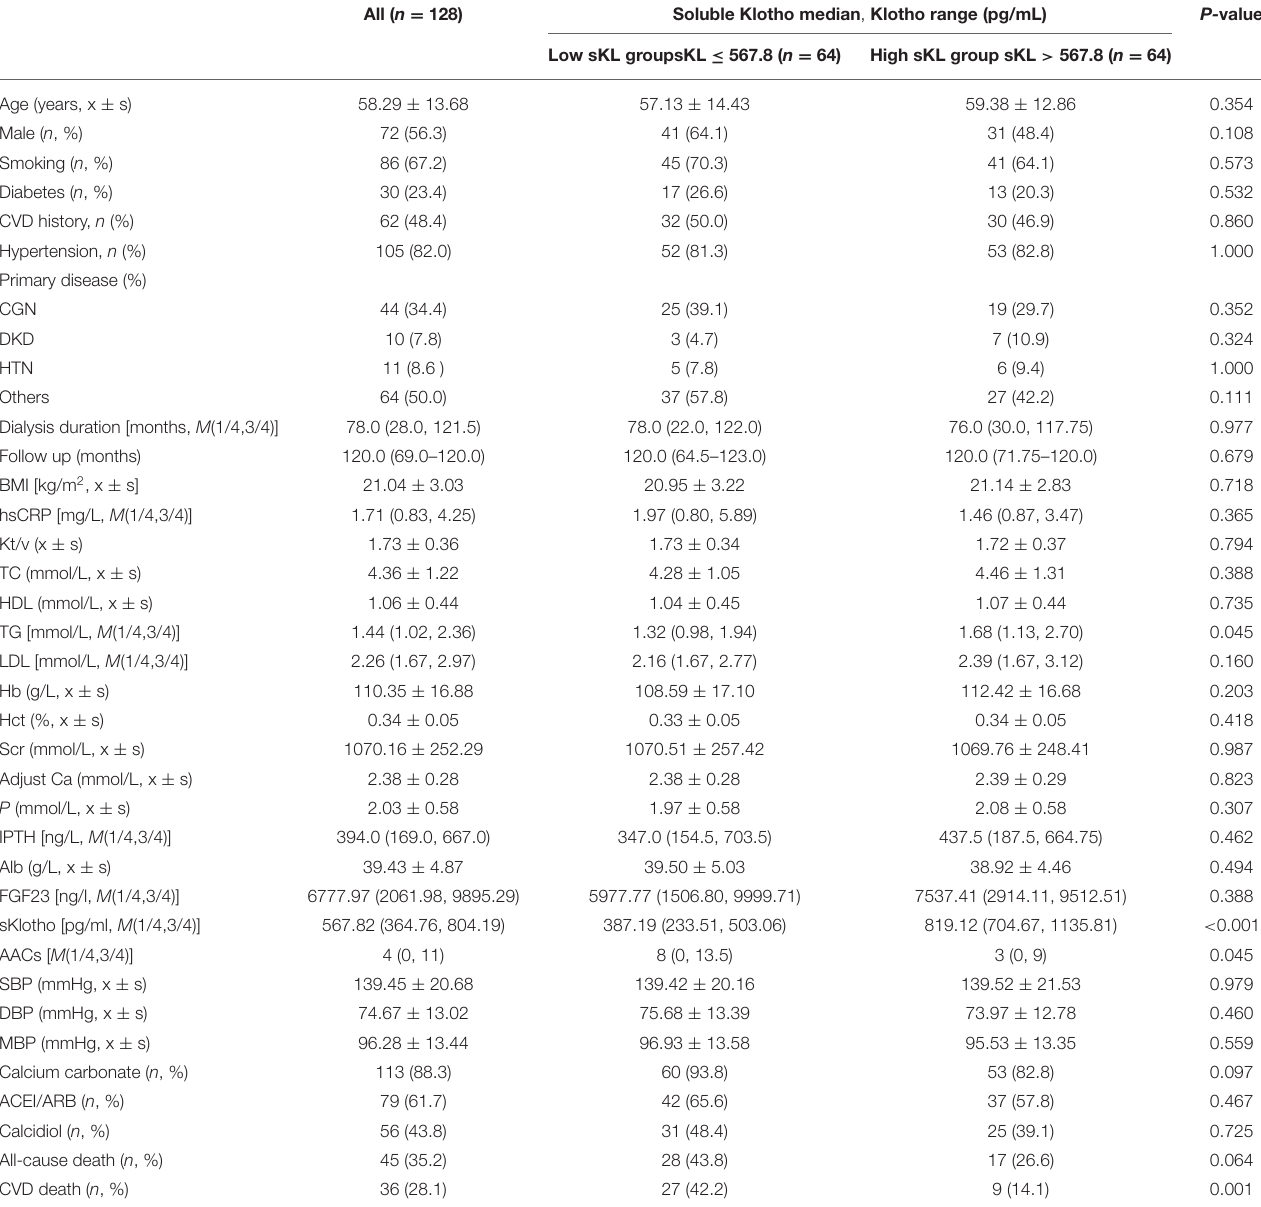
TABLE 1 | Baseline characteristics of community-living individuals and laboratory data by median of serum Klotho. All ( n = 128) Soluble Klotho median , Klotho range (pg/mL) P- value Low sKL groupsKL ≤ 567.8 ( n = 64) High sKL group sKL > 567.8 ( n =